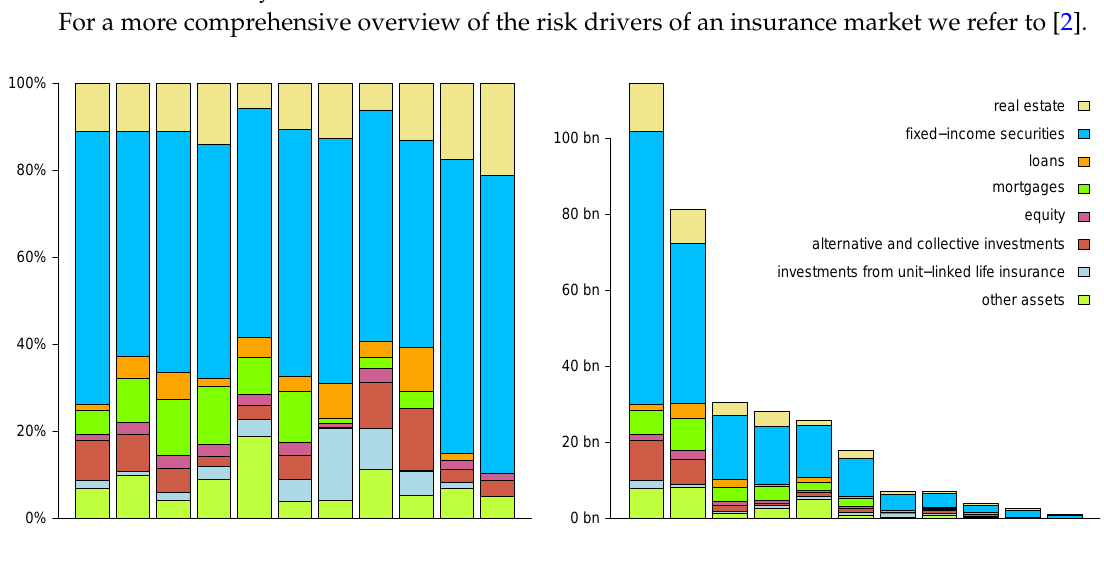
Figure 2. Asset allocations of 11 large Swiss life insurers by the end of year 2014, see [3]. The values shown are in percentage (lhs) and in billion Swiss franc (rhs),